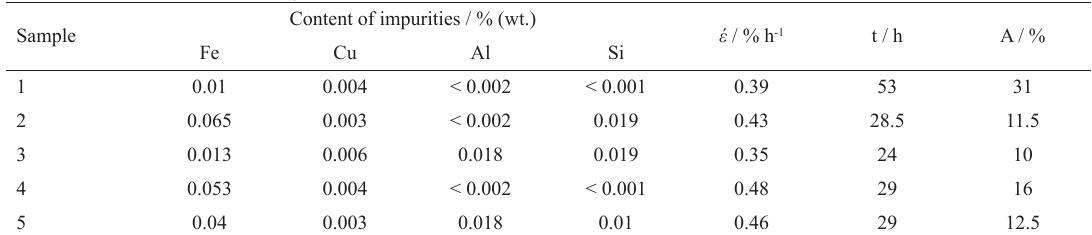
Table 5: The values of the creep rate, rupture time and relative elongation depending on the content of impurities at a temperature of 1400 °C, at a stress of 5 MPa, for the alloy PtRh10Pd25Ru1.5